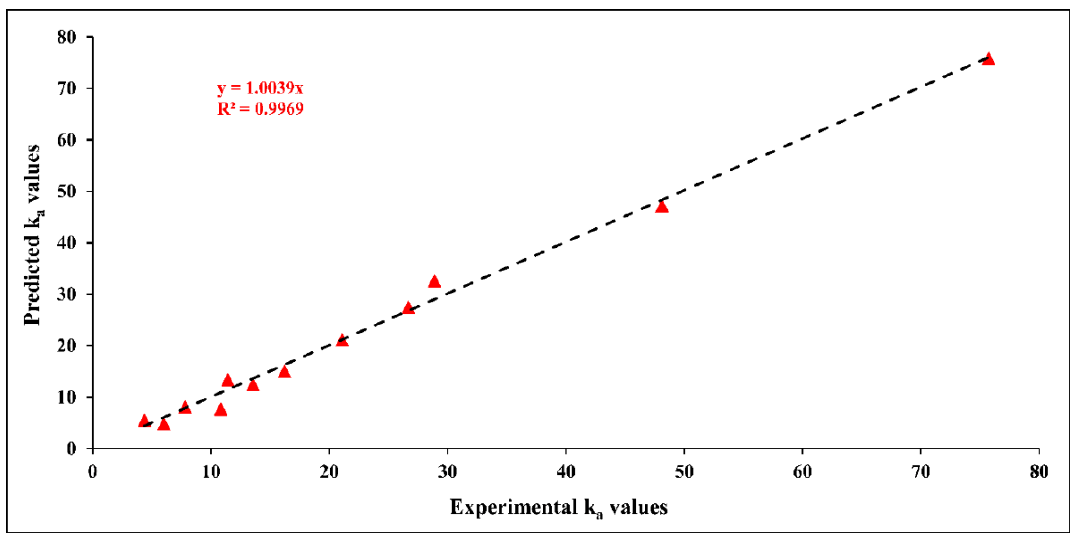
Figure 12. A comparison between experimental and predicted (k a × 10 3 ) values for the empirical power law kinetic model.